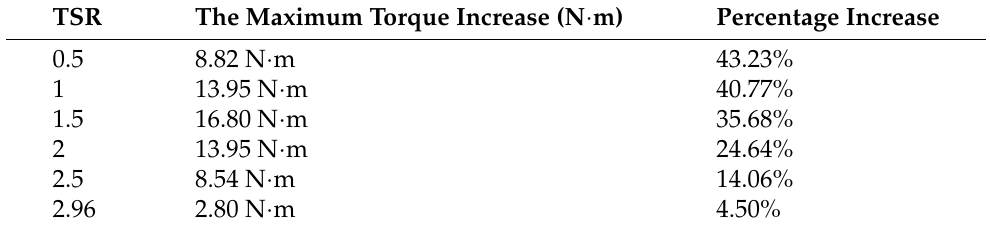
Table 5. Variation of maximum instantaneous torque of blades after optimization.